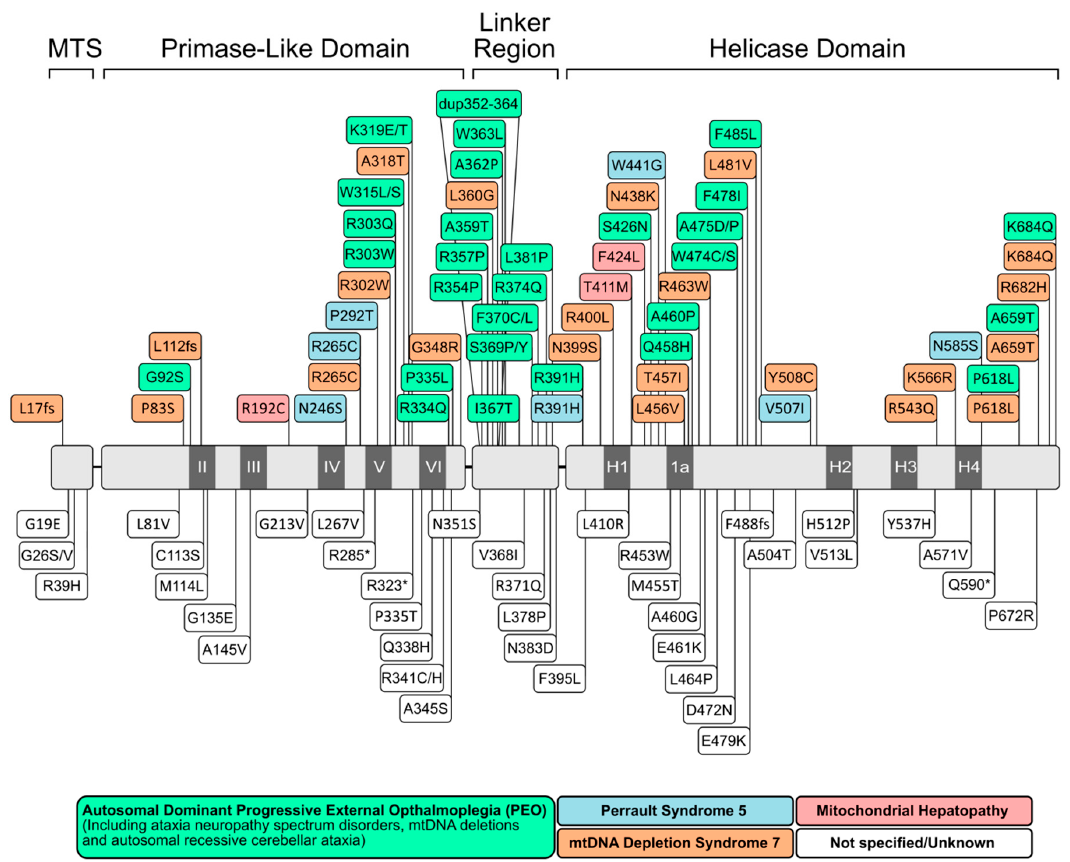
Figure 4. Disease-causing mutations and polymorphisms in the TWINKLE helicase. The domain organization of TWINKLE containing the conserved primase (II–VI) and helicase (H1–H4) motifs is shown. MTS—mitochondrial targeting sequence. The list of mutations was generated based on reported mutations and polymorphisms in the online Mendelian inheritance in man/OMIM database [102]. The upper region shows all reported mutations associated with disease while the lower region shows reported mutations for which a disease phenotype is uncertain or has not yet been described. Note the clustering of disease-causing mutations in the primase-like domain and linker helix regions. Green—adPEO and other ataxia neuropathy spectrum disorders (MIRAS, SANDO). Blue—Perrault syndrome. Pink—mitochondrial hepatopathy. Orange—mtDNA depletion syndrome (including IOSCA). White—not specified / not yet linked to